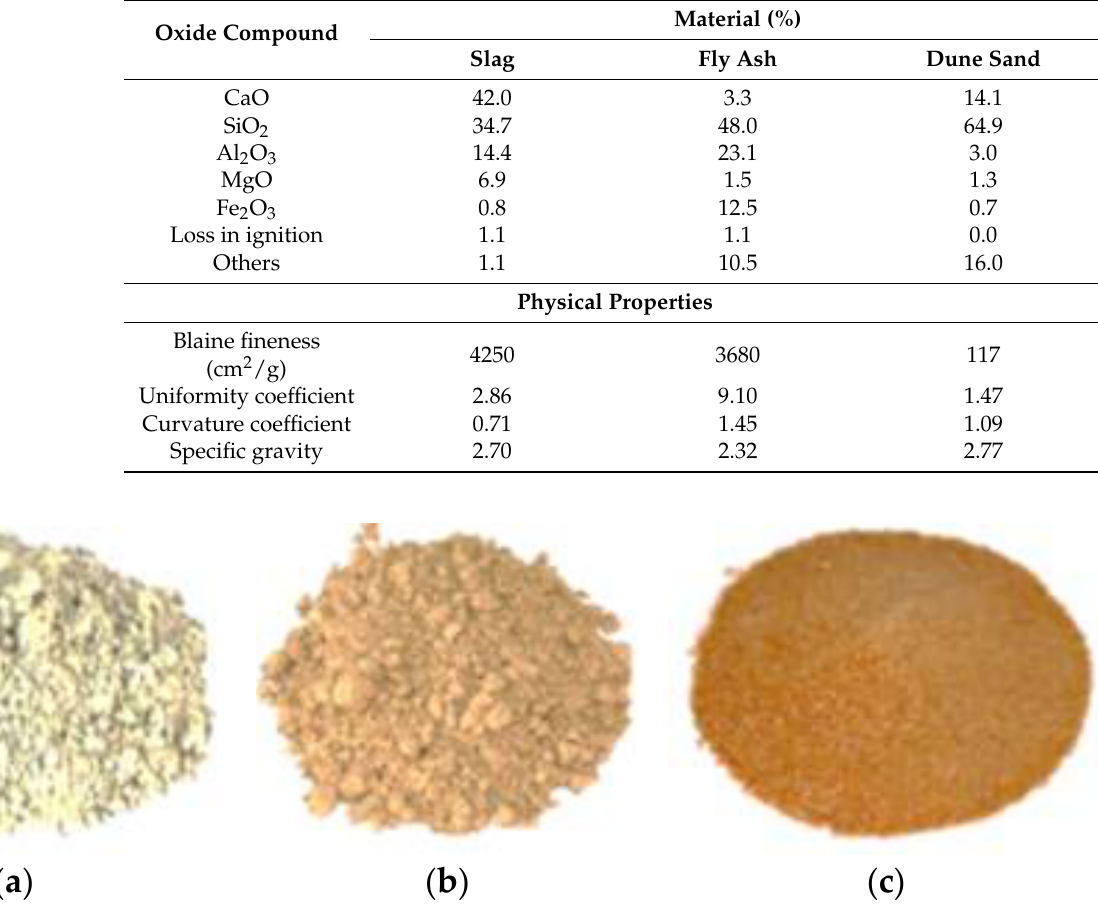
Table 1. Chemical composition and physical properties of the as-received materials.